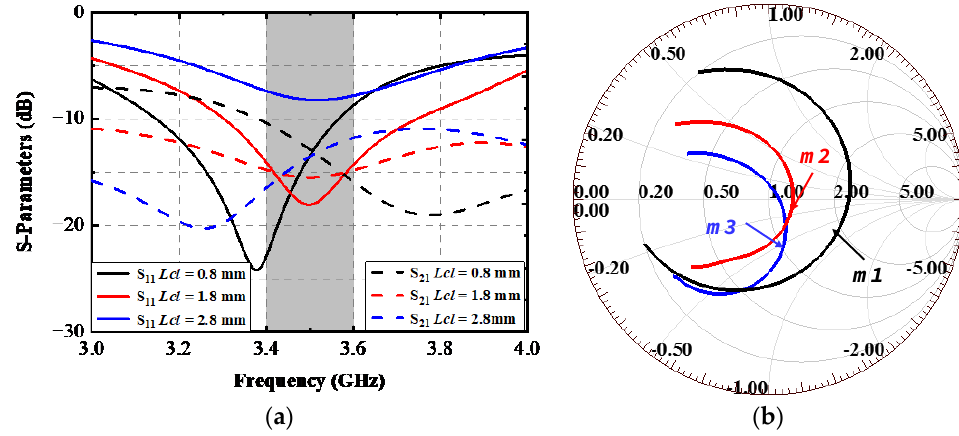
Figure 6. Simulated ( a ) S-parameters and ( b ) Smith chart with various Lcl values.